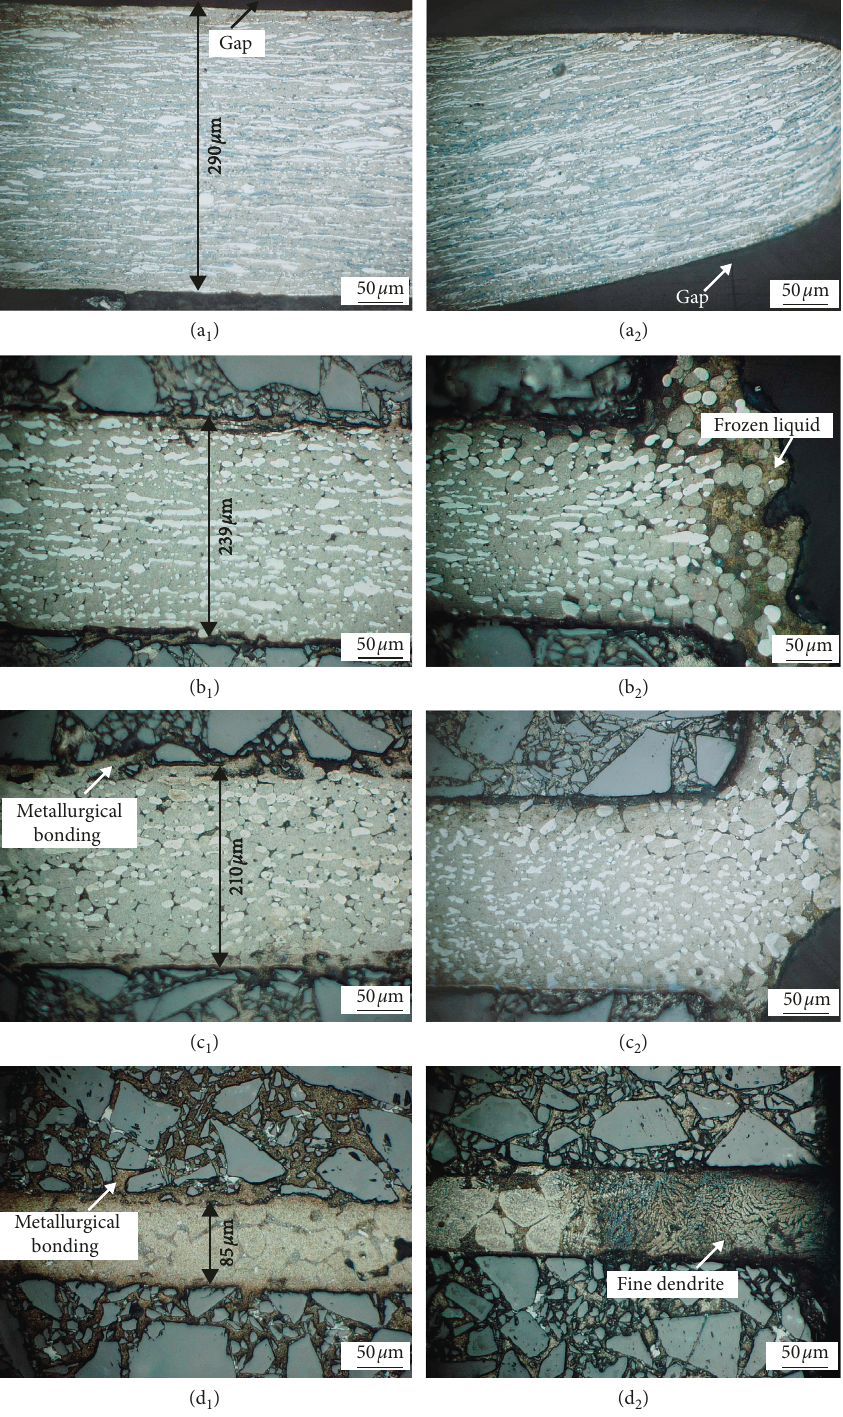
Figure 7: The microstructure of the as-rolled filler metal heated to different temperatures with compression between the SiC (a 1 )–(d 1 ) center region and (a 2 )–(d 2 ) edge region of the filler metal heated to 382 ° C, 386 ° C, 392 ° C, and 410 °